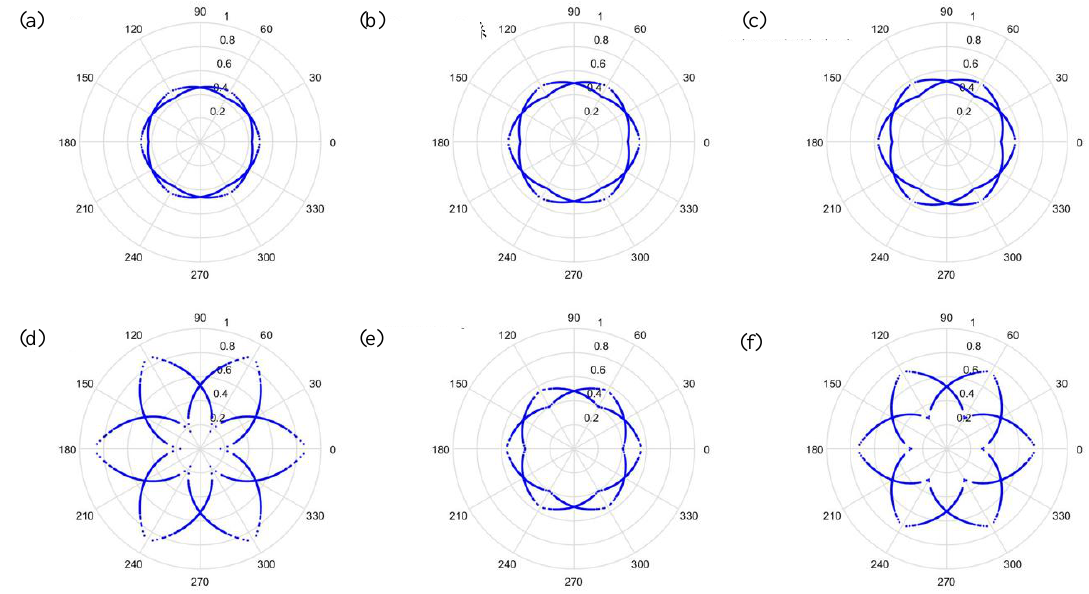
Figure 16. Results from improved formula when t = 0 and sampling is at 3000 Hz / 2000 rpm. ( a ) Normal, ( b ) motor platform with one eccentric screw, ( c ) motor platform with two eccentric screws, ( d ) sanded ball bearings, ( e ) insufficient lubrication, and ( f ) worn ball bearings.